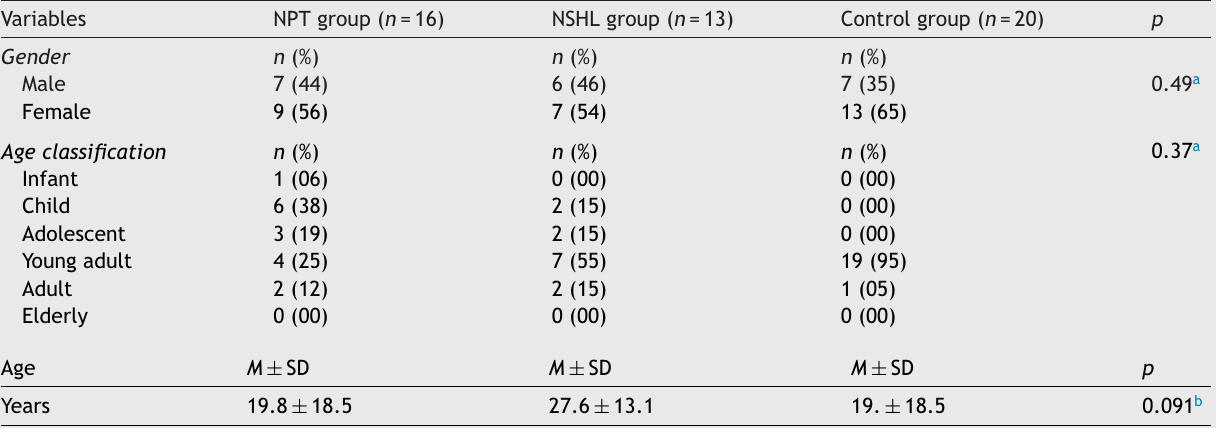
Distribution of demographic variables of index cases in the NPT group, patients from the NSHL group, and individuals from the Control group.